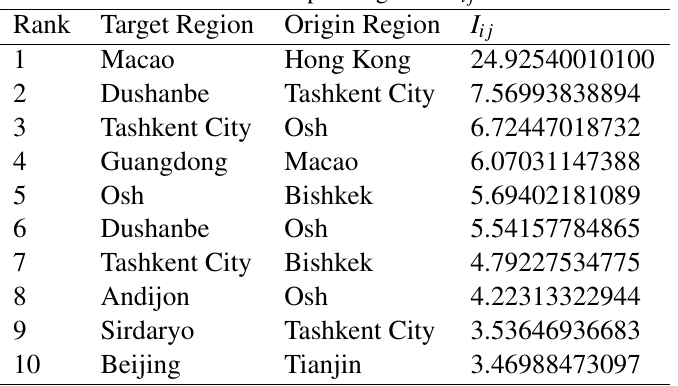
Table 2 Top 10 region of I ij